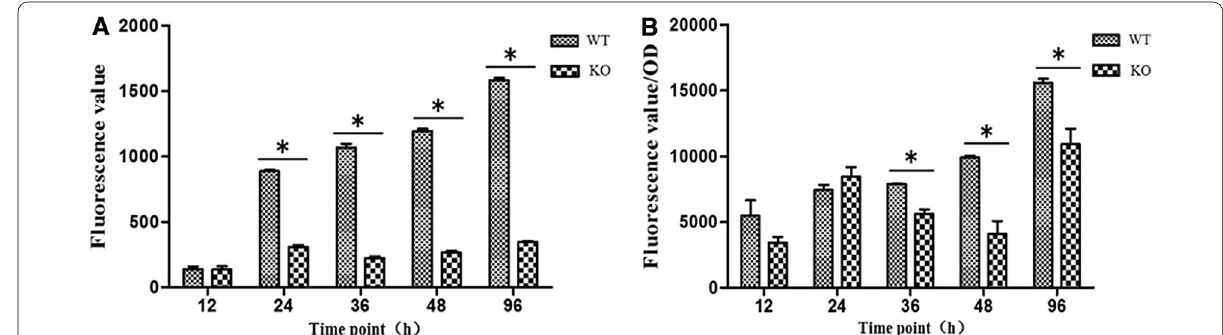
Fig. 4 The content (mean and SD) of coenzyme F 420 of WT and KO M. ruminantium in different culture time. A the content of coenzyme F 420 of liquid; B the content of coenzyme F 420 per OD 600 . SD standard deviation, WT wild-type, KO knock-out